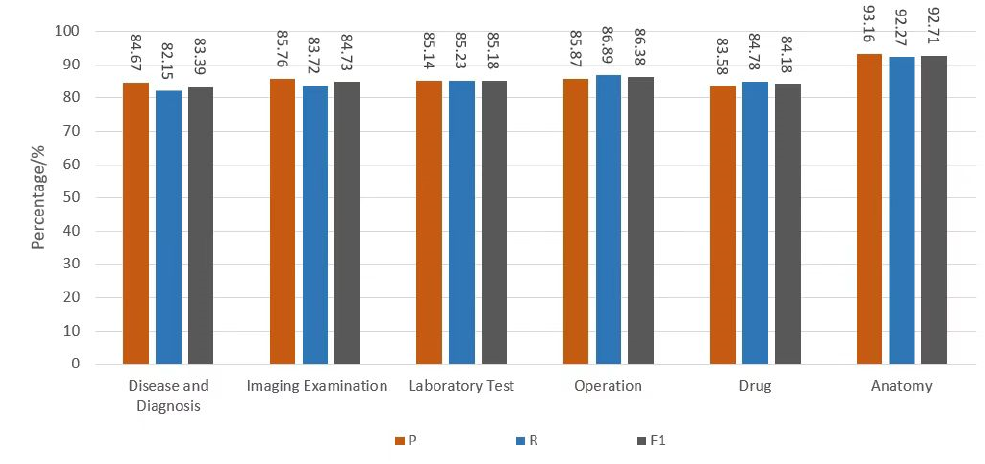
Figure 6. Statistics of various entity recognition